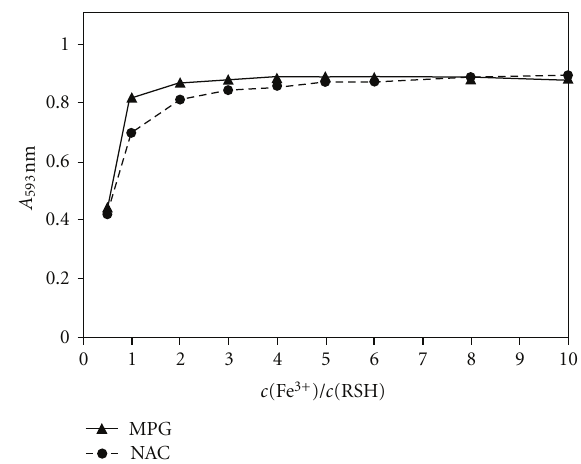
Figure 2: E ff ect of the Fe(III) concentration on the absorbance at 593 nm for the fixed concentration of 40 μ M for the thiol (RSH) compound, that is, NAC or MPG, at pH 3.6 and 25 ◦ C. The concentration of TPTZ was 0.2 mM.